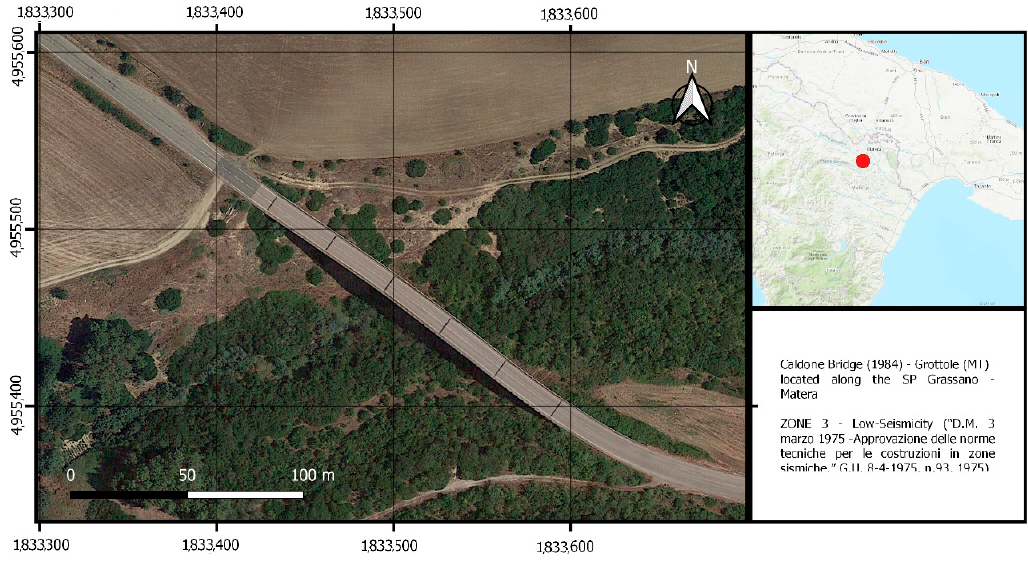
Figure 5. Location of the study area (Google Maps © 2020–Maxar Technologies).